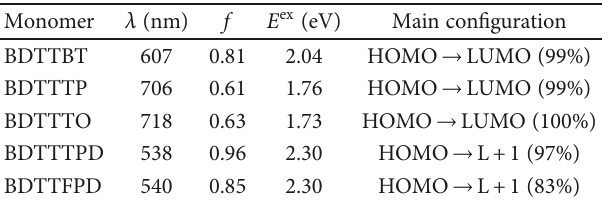
Table 1: Maximum absorption wavelengths ( λ ), oscillator strengths ( f ), the lowest excitation energies, and main con fi guration of